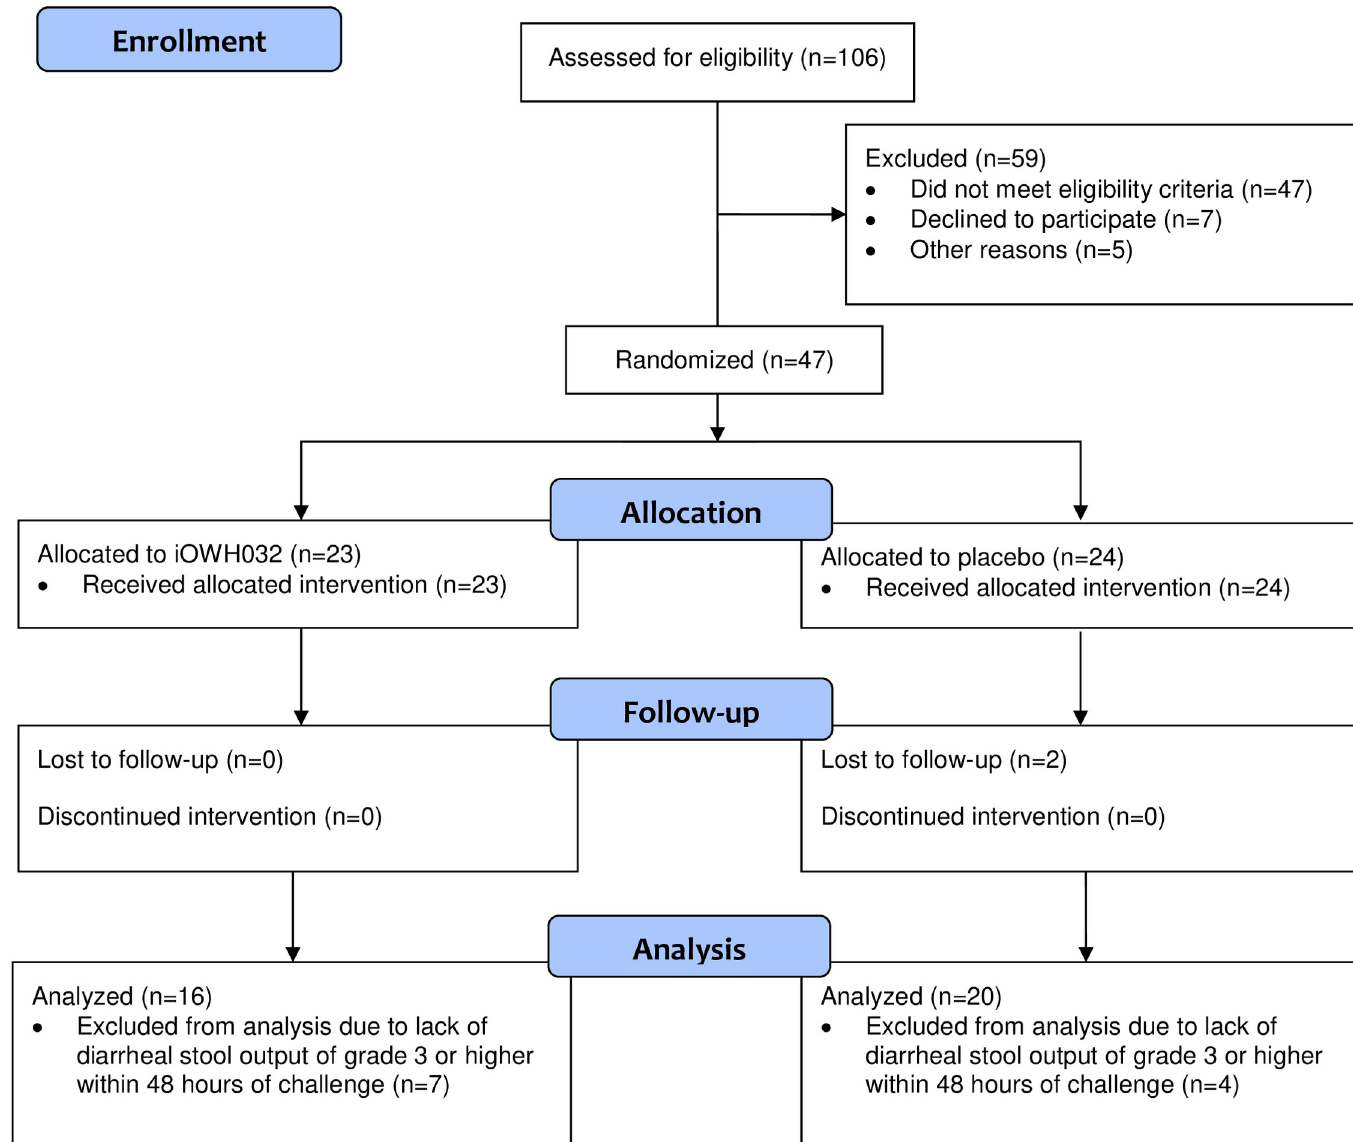
Fig 1. Consolidated Standards for Reporting of Trials flow